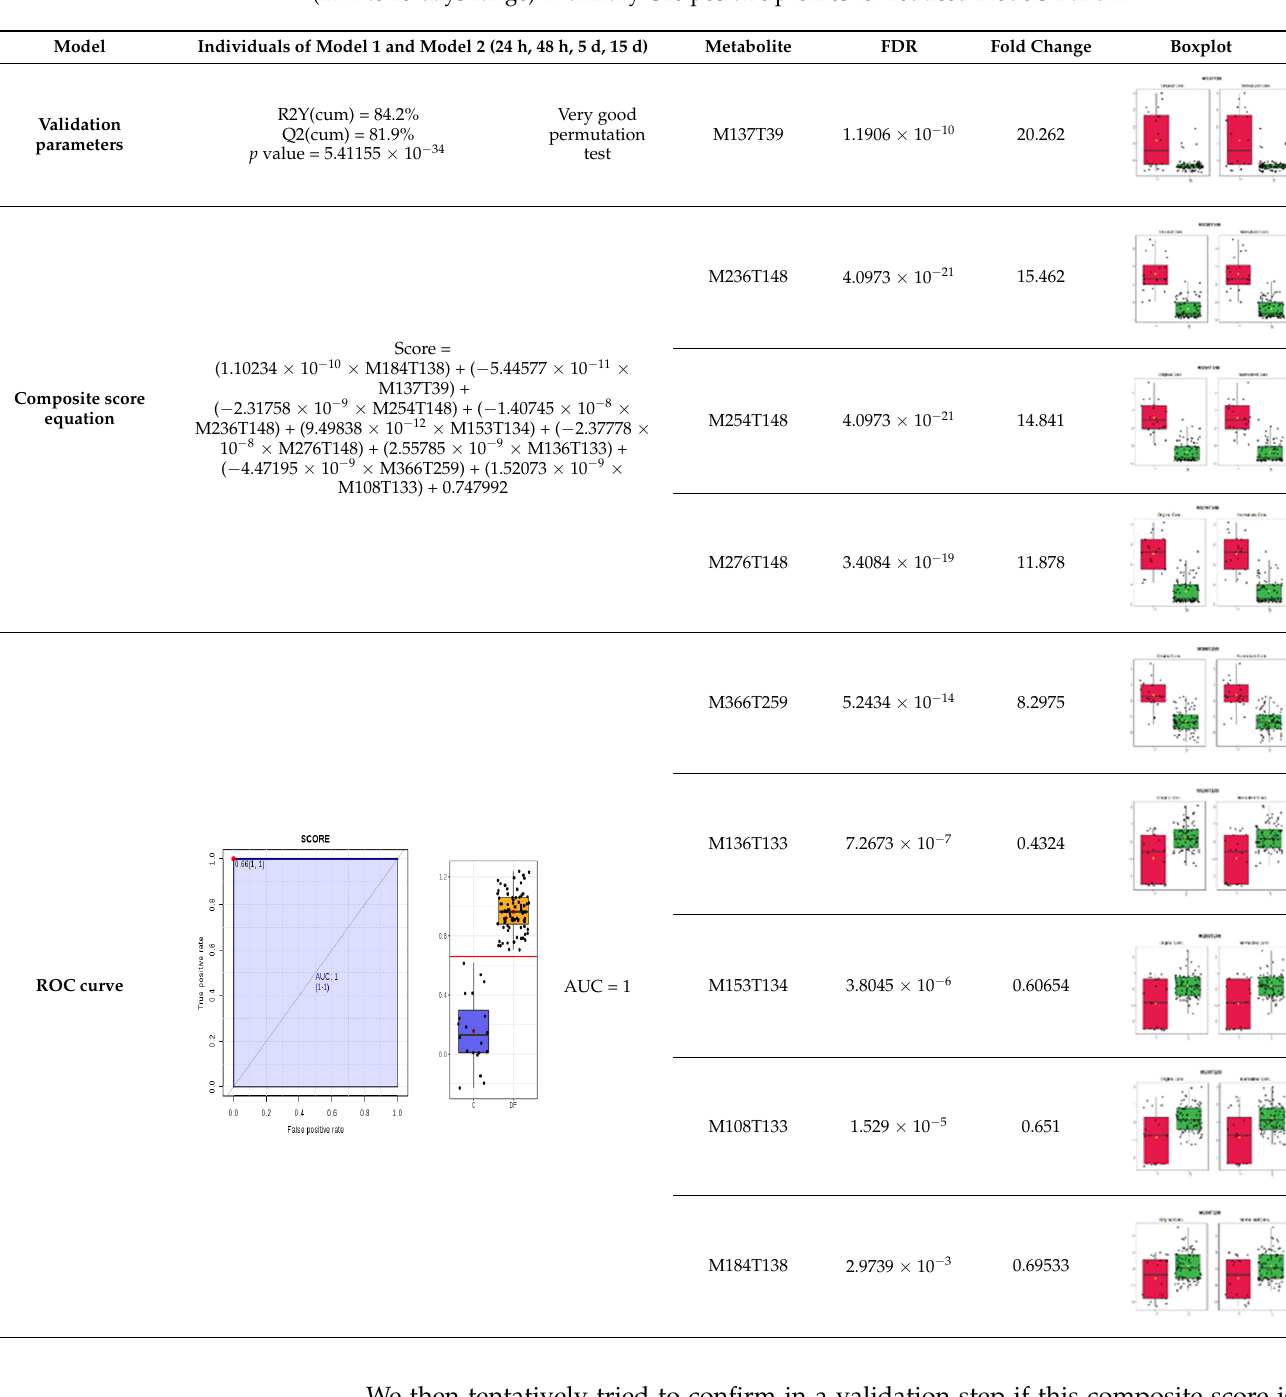
Table 2. Composite score based on the nine common discriminant biomarkers for the early period (24 h to 15 days range) in urinary C18 positive profiles for reduced models 1 and 2.